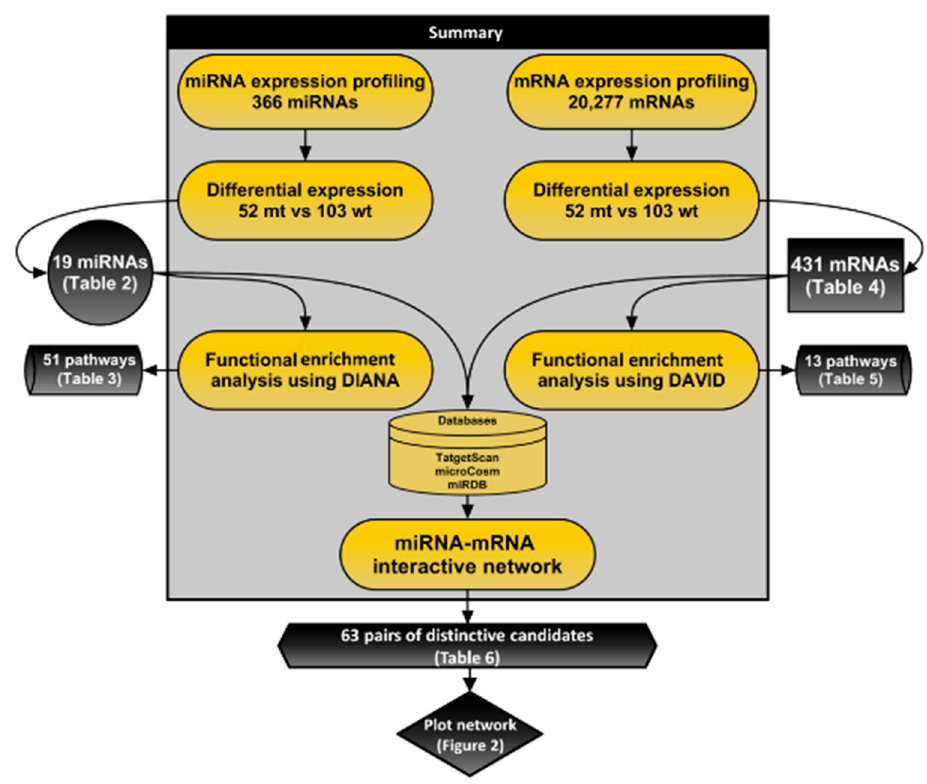
Figure 1. Flow diagram for predicting the target relationship between miRNA–mRNA pairs. Table 1. Clinicopathological characteristics of 155 cases of lung adenocarcinoma stratified by EGFR mutation status.